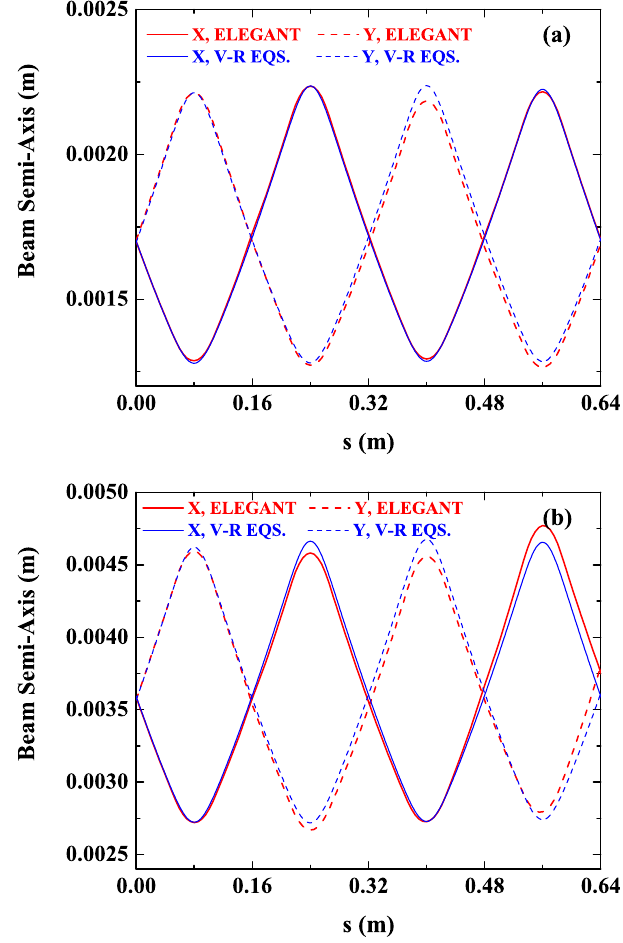
FIG. 7. Envelope functions from ELEGANT and the V-R equa- tions with no dispersion, over one superperiod in UMER, for (a) 0.6 mA and (b) 6.0 mA. Notice that the scales between (a) and (b) differ by a factor of 2. See Table I for additional